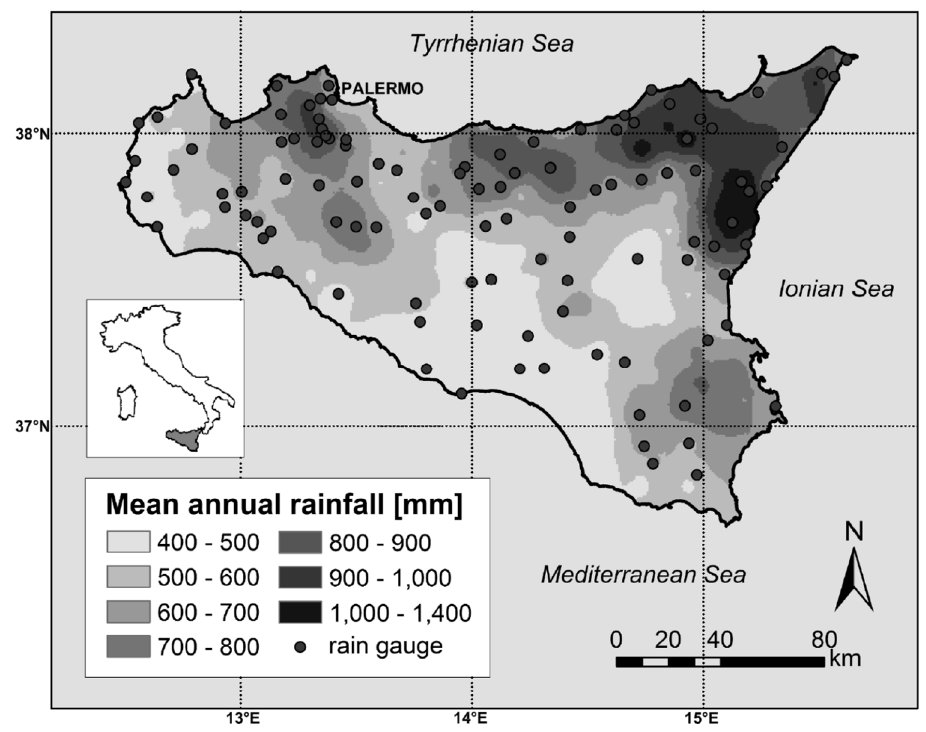
Figure 1. Spatial distribution of mean annual rainfall for the 1981–2012 period and locations of rain gauges.